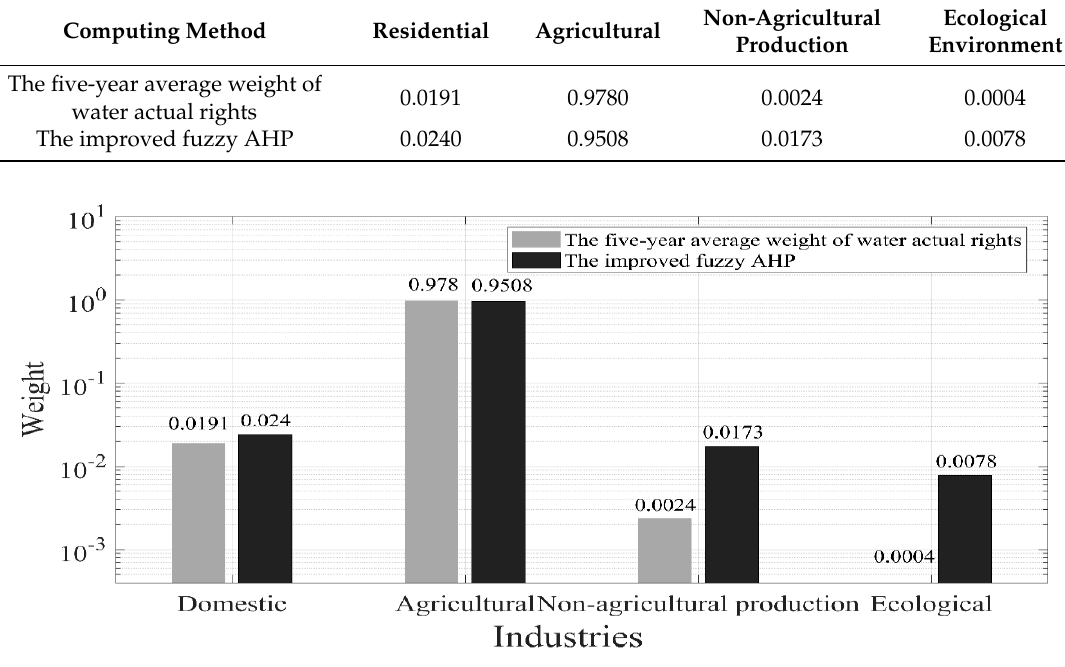
Figure 4. The weight of initial water rights of improved fuzzy AHP in comparison with that of the actual five-year average.